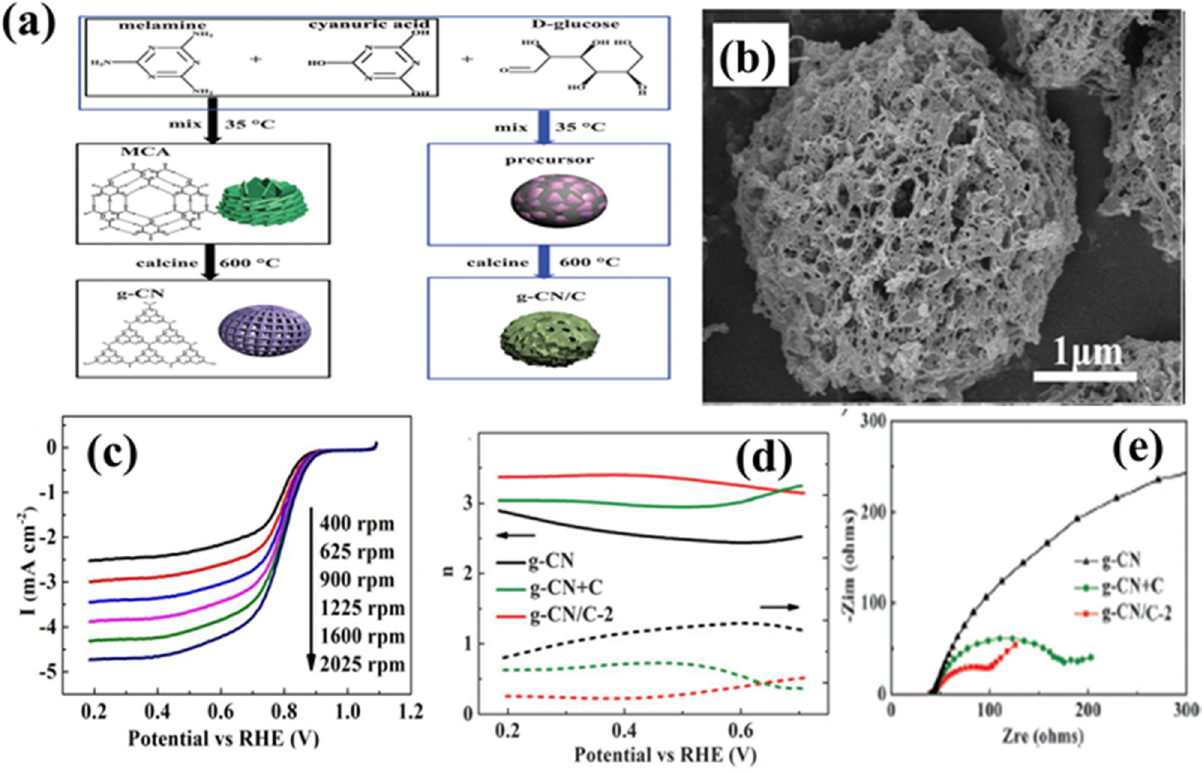
Figure 2. ( a ) Schematic illustration of the synthesis of g–CN and g–CN/C, ( b ) SEM images of g–CN/C–2, ( c ) LSV polarization curve for ORR, ( d ) evaluation of n value, ( e ) EIS studies of the g– CN/C–2, g–CN + C, g–CN, adapted from [46].